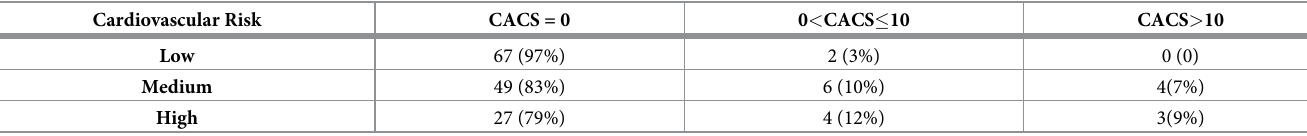
Table 3. Coronary calcification divided to three categories by cardiovascular risk.